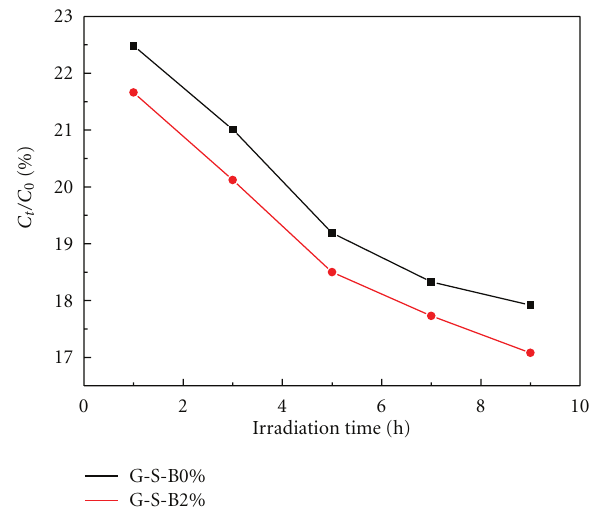
Figure 5: Atrazine degradation in present of goethite and B-doped goethite under visible light. Table 1: The properties of di ff erent B-doped goethite and hematite. Samples BET(m 2 /g)